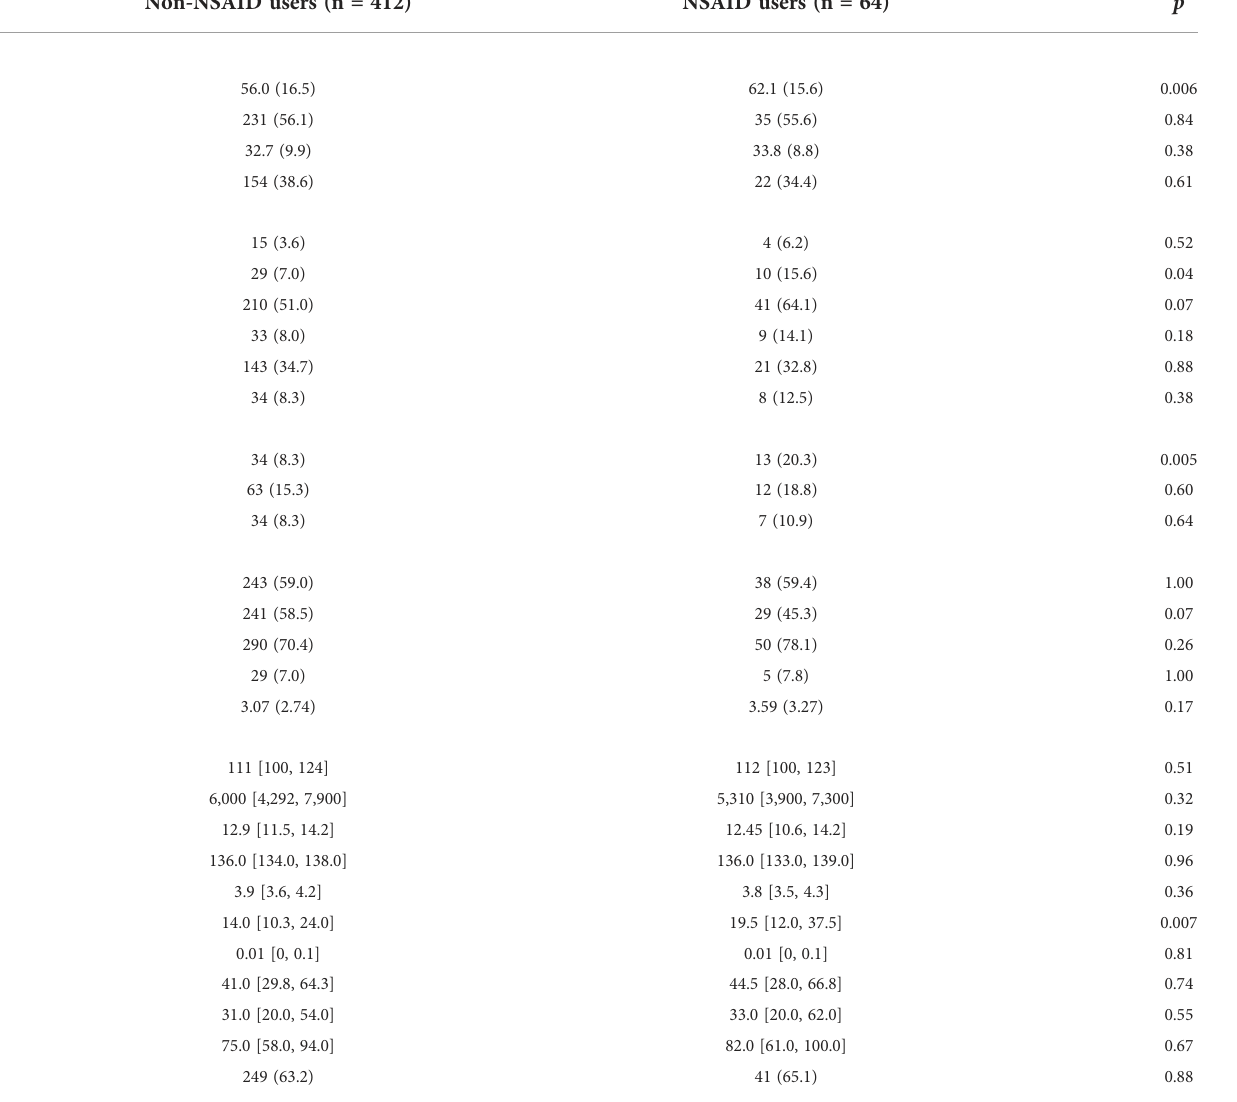
TABLE 1 Baseline characteristics of included hospitalized COVID-19 patients strati fi ed by NASIDs